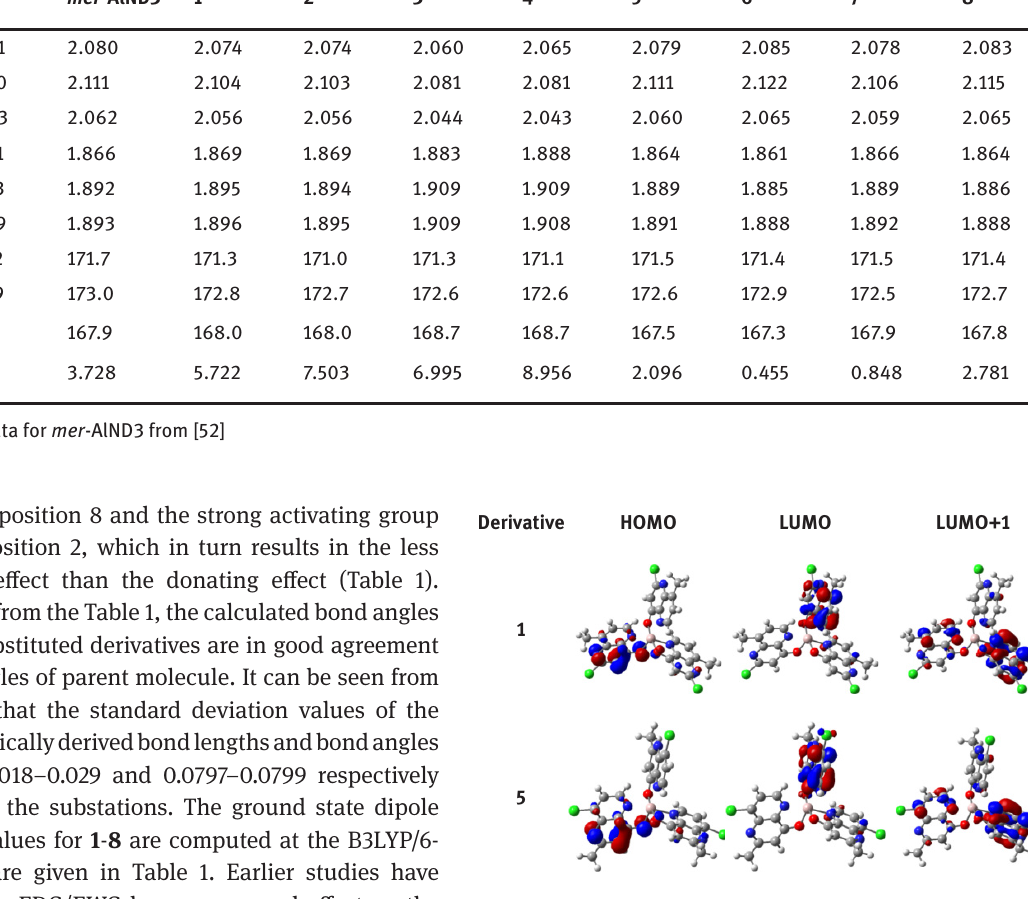
Figure 2: Frontier molecular orbitals (FMOs) for the ground states (S of disubstituted derivatives of mer -AlND3 (1(type I) and 5 (type II)) computed at B3LYP/6-31G(D)